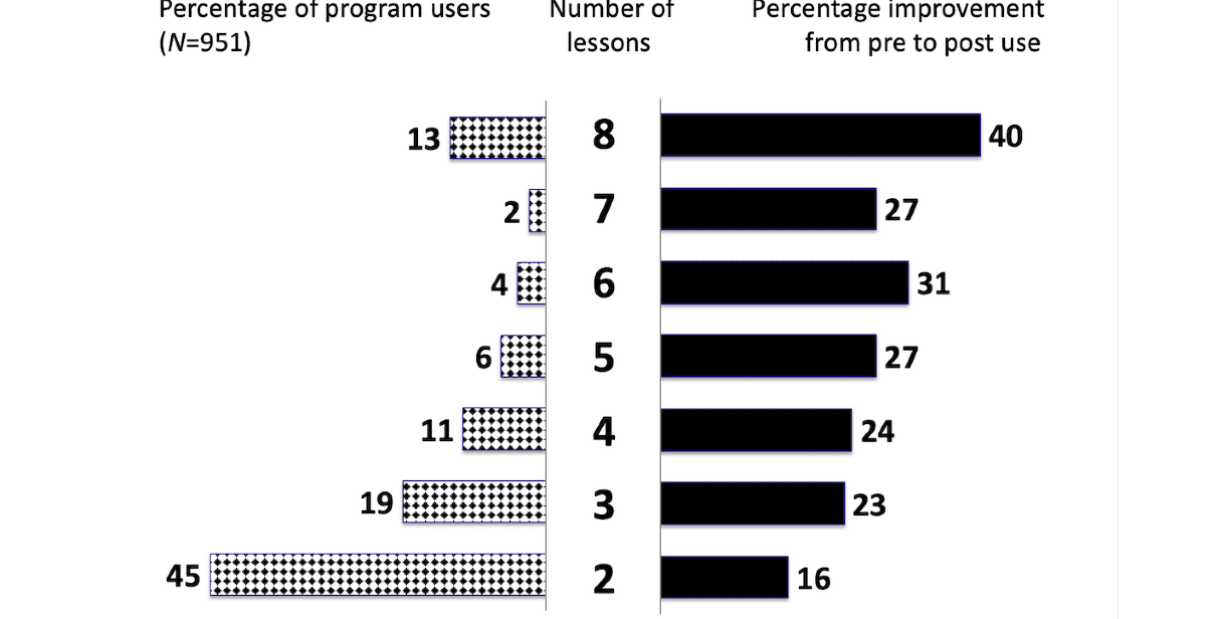
Figure 1. Results in total sample across internet-based cognitive behavioral therapy programs for moderating effect of greater number of lessons used (center) associated with greater improvement in clinical symptom severity (right side) and percentage of users at each level of lessons (left